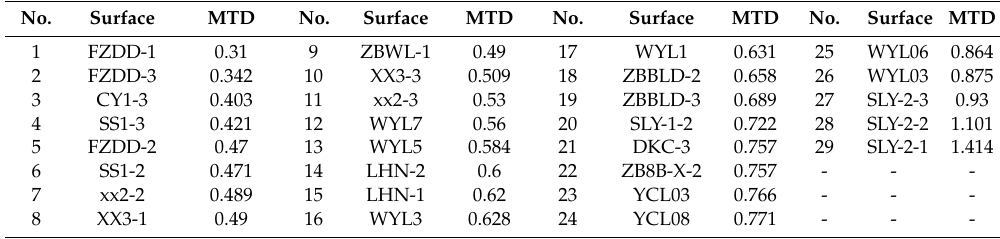
Table 1. Mean texture depth (MTD) of the selected surfaces